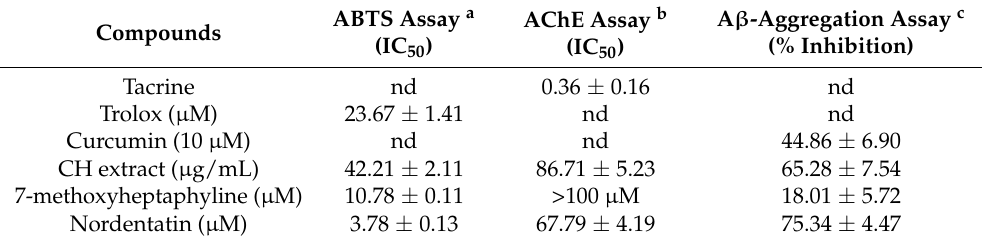
Table 2. The effects of the CH root extract and its constituents on ABTS-radical scavenging, AChE activity, and A β aggregation. All determinations were assessed in triplicate wells at least three times. ABTS Assay Compounds